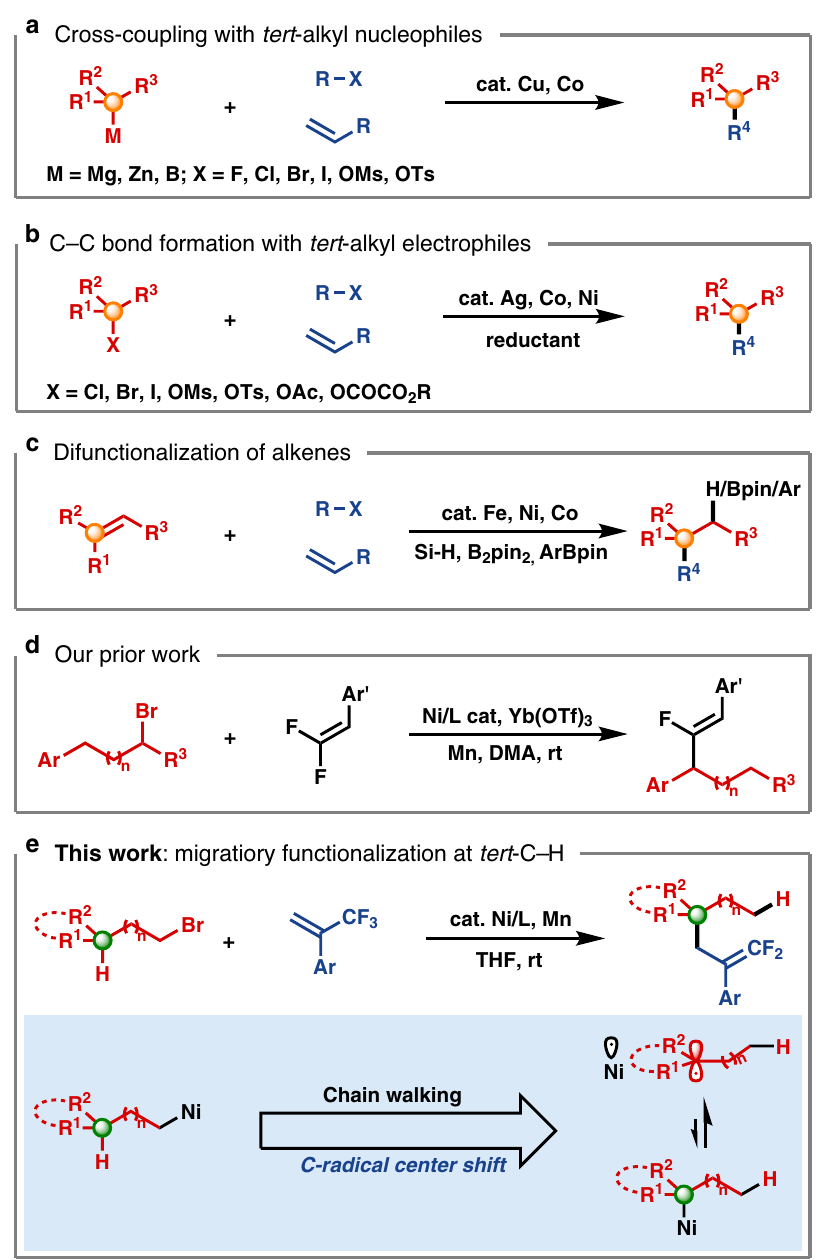
Fig. 1 Transition metal catalyzed formation of quaternary centers. a Standard cross-coupling approach, b cross-electrophile coupling, c difunctionalization of alkenes, d our prior work, e di fl uoroallylation of alkyl bromides with chain walking via transition-metal-catalyzed tert -C – C bond-